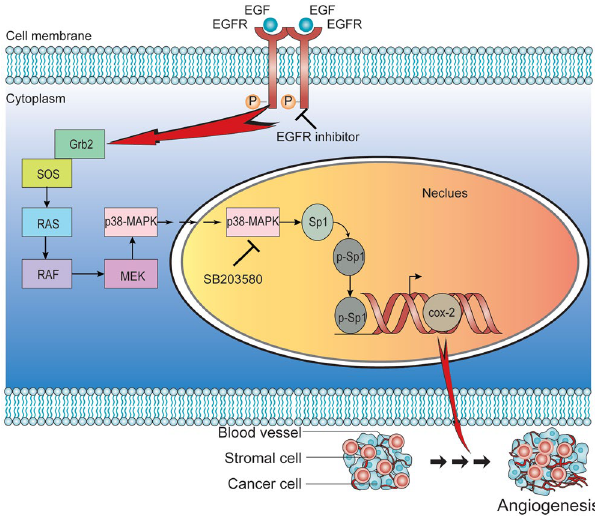
Figure 6. Schematic overview summarizing the functional significance and regulation of COX-2 in PDAC. Overactive EGFR phosphorylates Sp1 via a p38-MAPK signalling pathway. The highly activated Sp1 subsequently activates COX-2 transcription, leading to elevated COX-2 expression, which finally promotes the secretion of